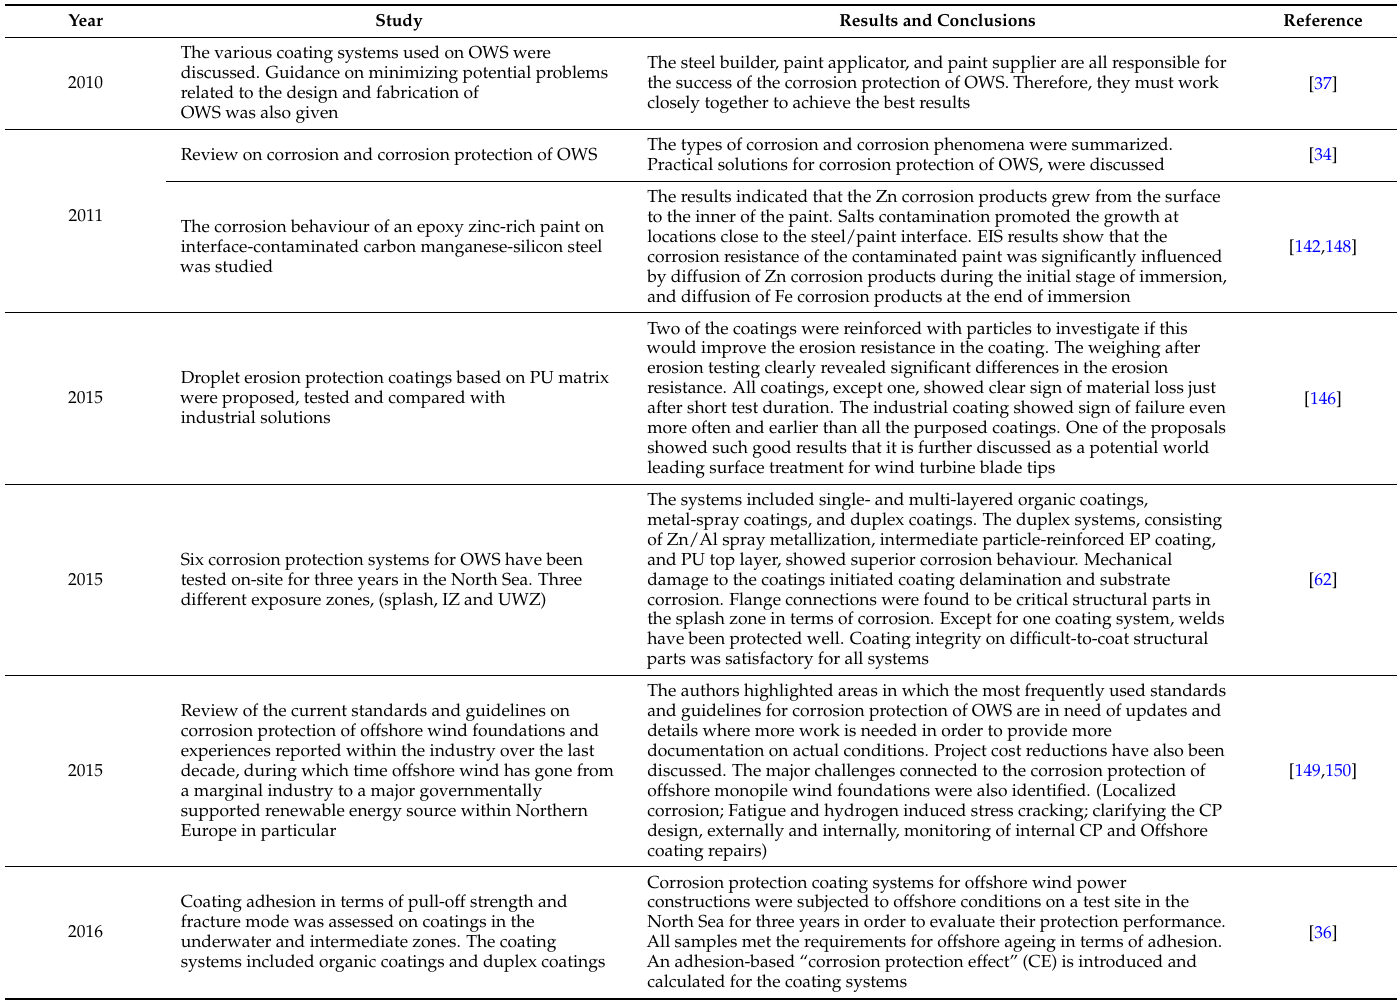
Table 8. Published papers between 2010–2016 regarding corrosion protection systems and fatigue